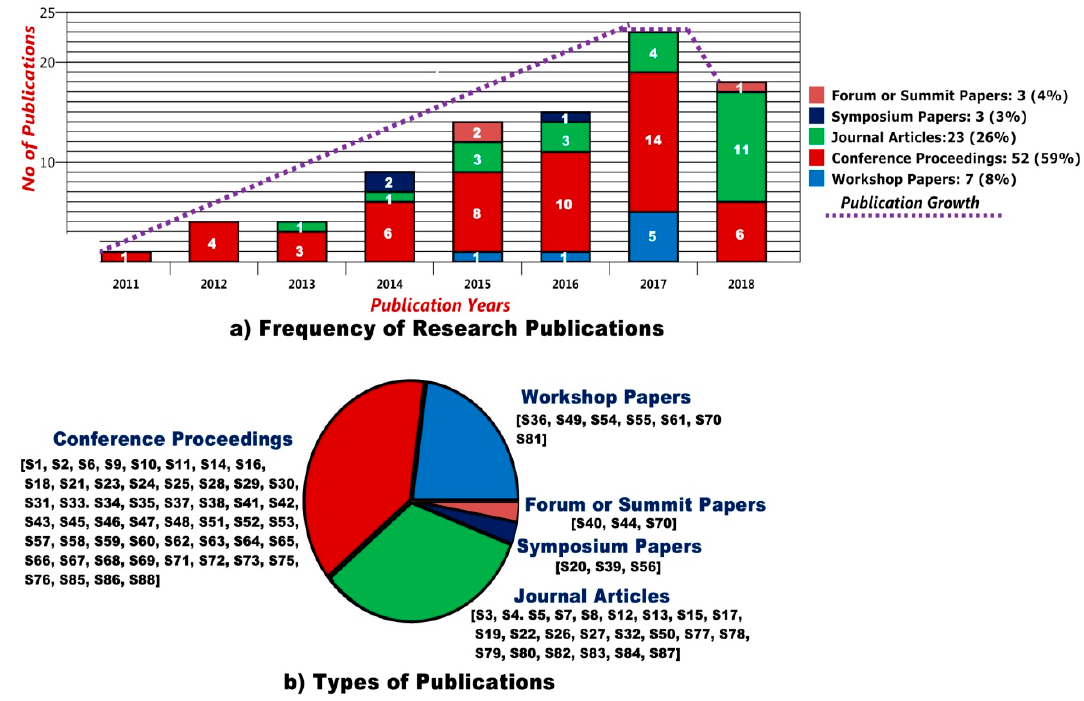
Figure 6. An Overview of the Frequency and Types of Publications.